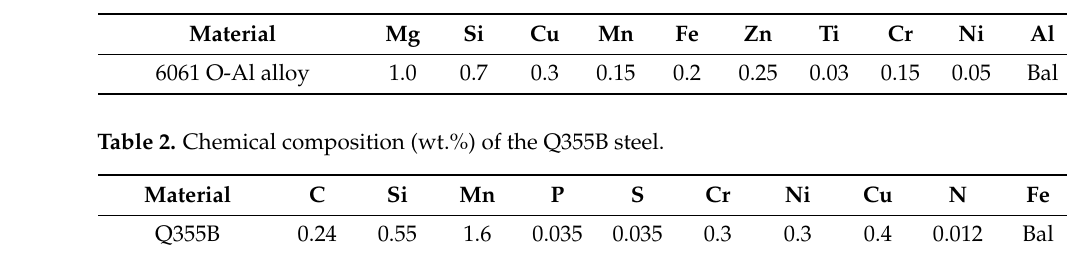
Table 1. Chemical composition (wt.%) of the 6061-O Al alloy.